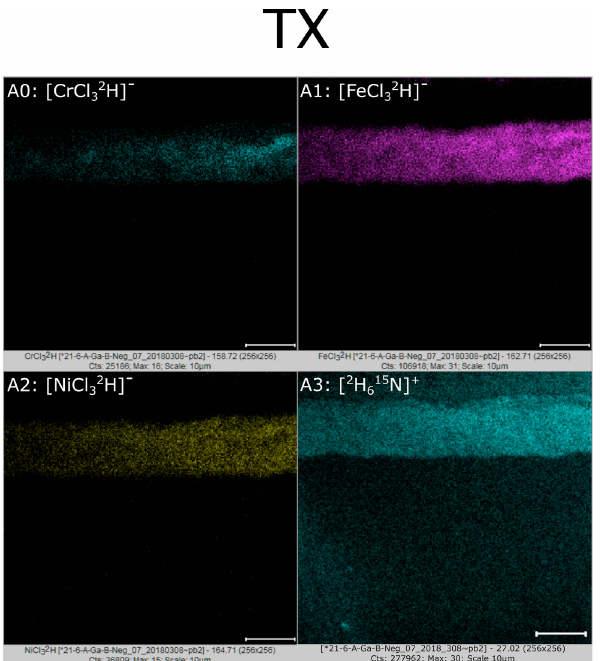
Figure 11. TX activated with 15 N 2 H 4 Cl: ToF-SIMS maps [CrCl 32 H] − , [FeCl 32 H] − , [NiCl 32 H] − as well as map of [ 2 H 615 N] +